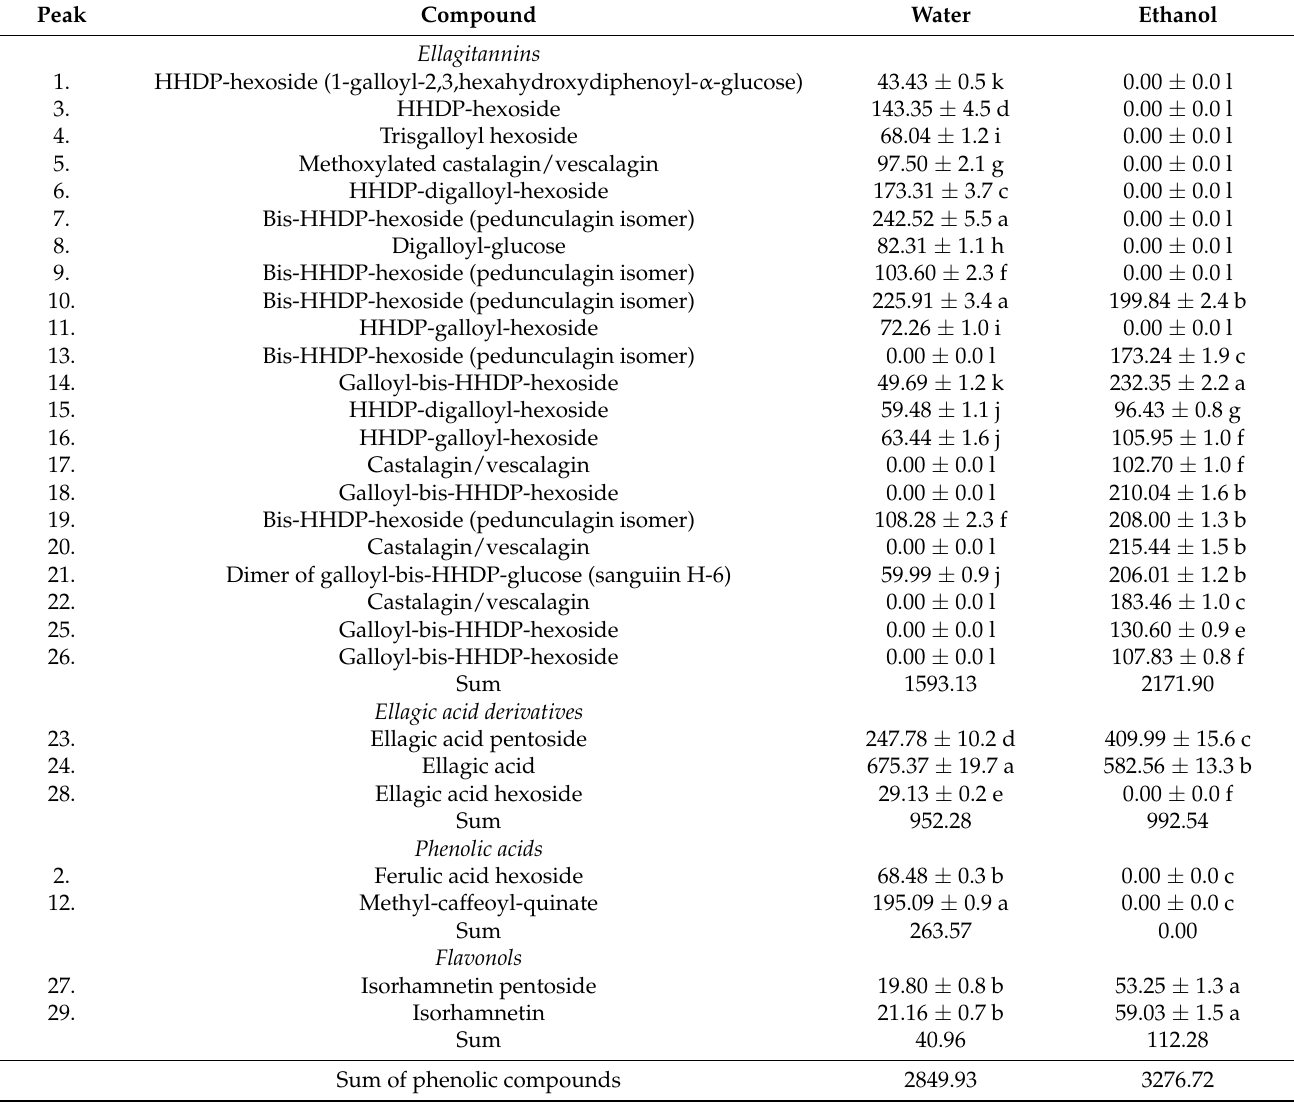
Table 2. Phenolic composition of different extracts of Alder acorns (mg/100 g of dry matter)